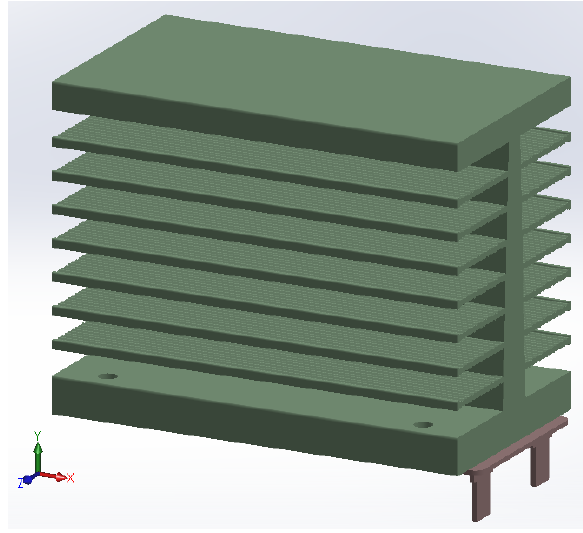
Figure 11. Velocity of 0.075 m/s on X axis, marked with the red arrow.